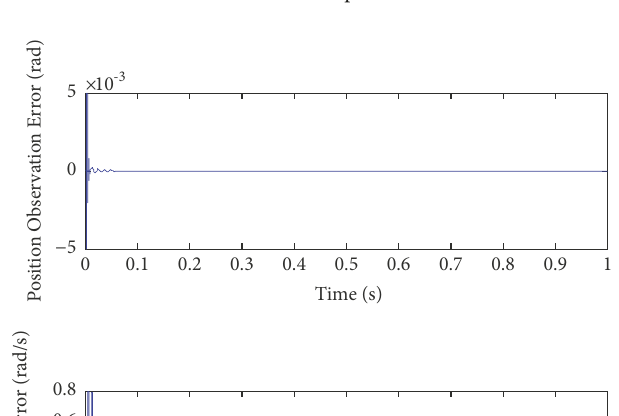
Figure 6: Control input of ODSC.